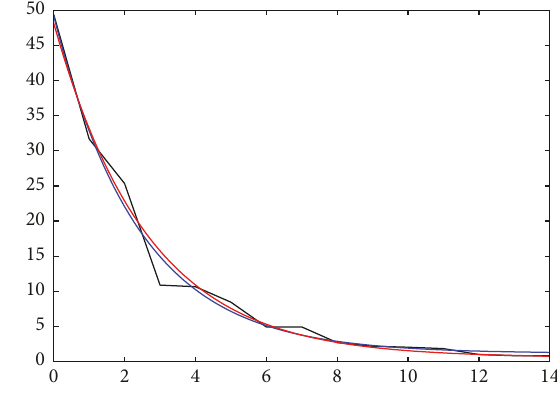
Figure 1: The function 𝑗 󳨃→ 𝑑 𝑗 (𝑥 0 ) in black, with the standard curve 𝐶2 −𝑗ℎ (blue) and the logarithmically corrected curve (using equality (80)) (red) obtained with the Levenberg-Marquardt